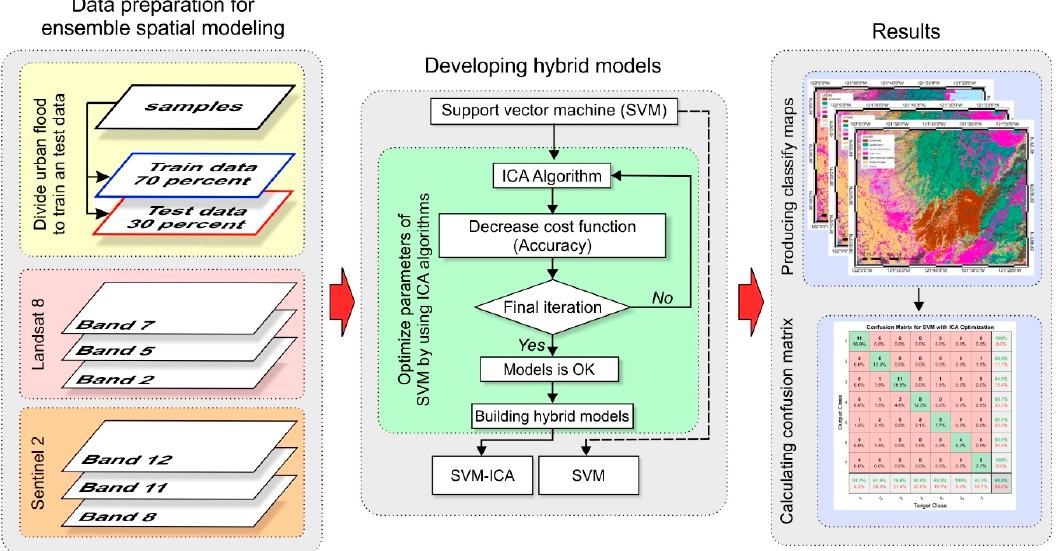
Figure 3. Workflow diagram of the pre- and post-wildfire mapping using SVM and SVM-ICA algorithms for Camp Fire occurrence. Along with the pre- and post-classification maps, an accuracy assessment was done for each map generated from this study.